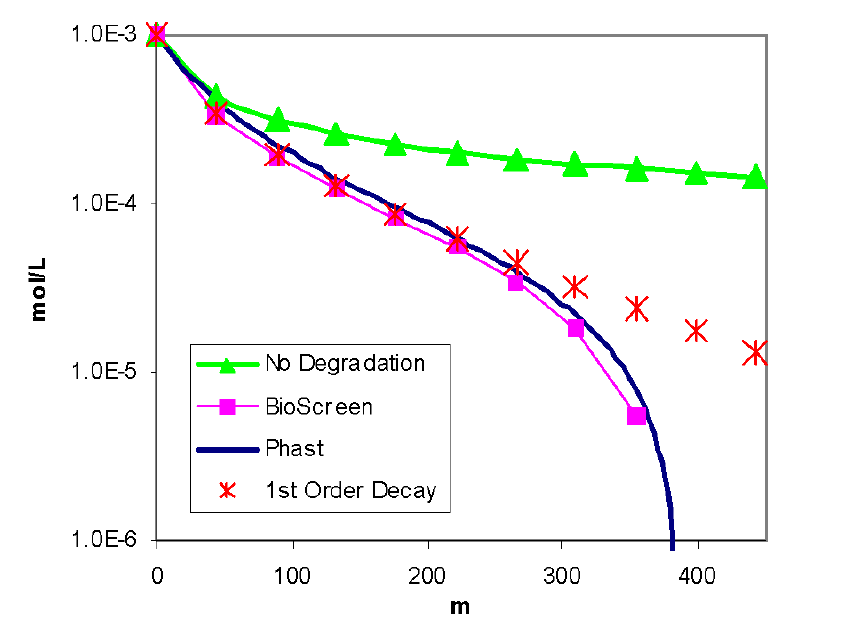
FIGURE 4. BIOSCREEN and PHAST simulations of hydrocarbon profiles in the plume centreline, hydrodynamic parameters being equal to the one used in Fig. 2. For first-order degradation, the fitted half-life is equal to 90